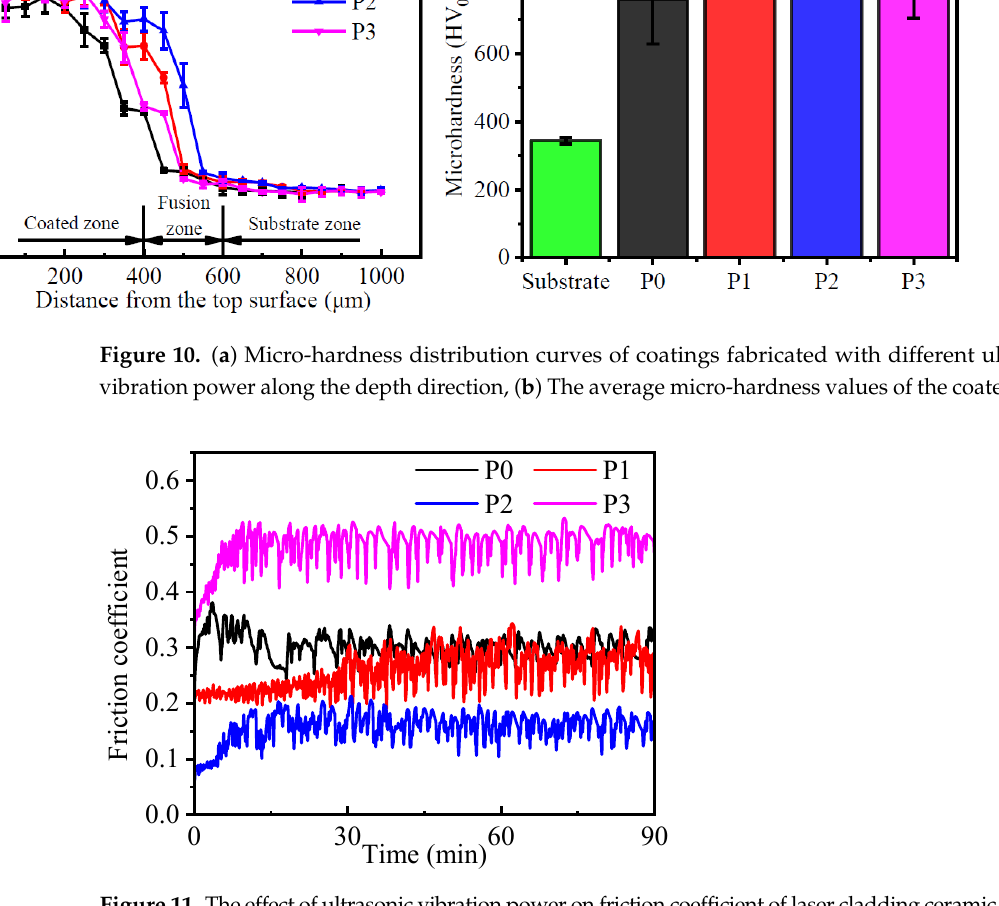
Figure 12. The effect of ultrasonic vibration power on wear of laser cladding ceramic coatings: ( a ) wear track profile, ( b ) wear volume loss.